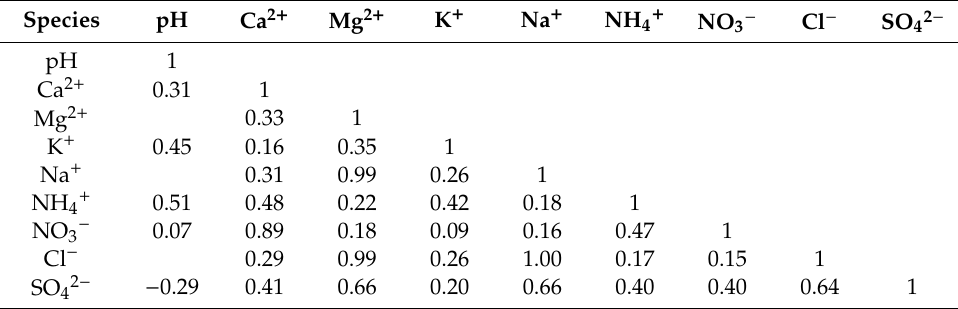
Table 1. Correlation coe ffi cient (r) matrix between concentrations of di ff erent species in wet deposition samples (NADP). Values shown are statistically significant at the 95% confidence